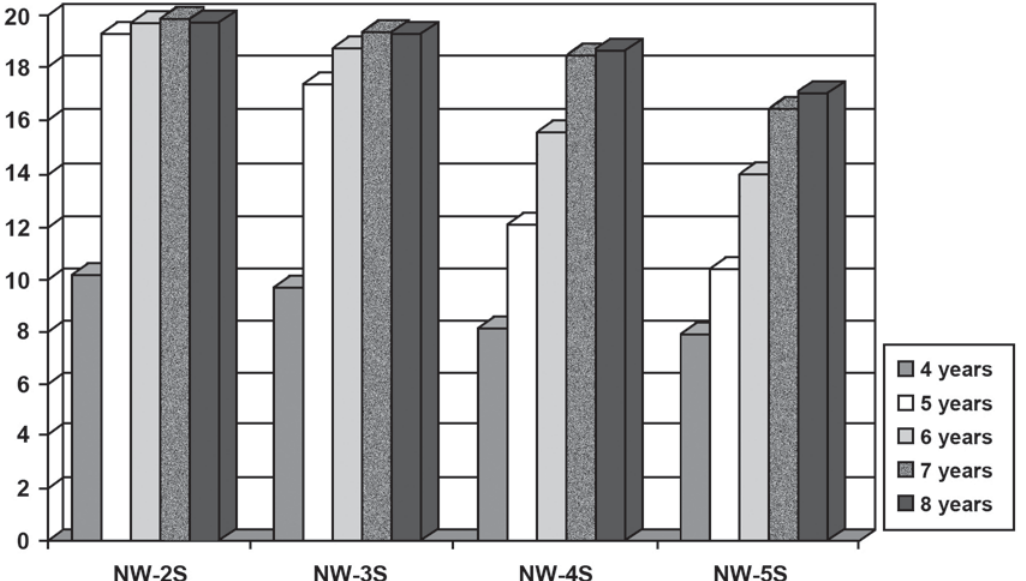
Figure 1- Descriptive measures of the performance of children aged 4 to 8 years according to the variable number of syllables. Legend: NW- nonword; S-